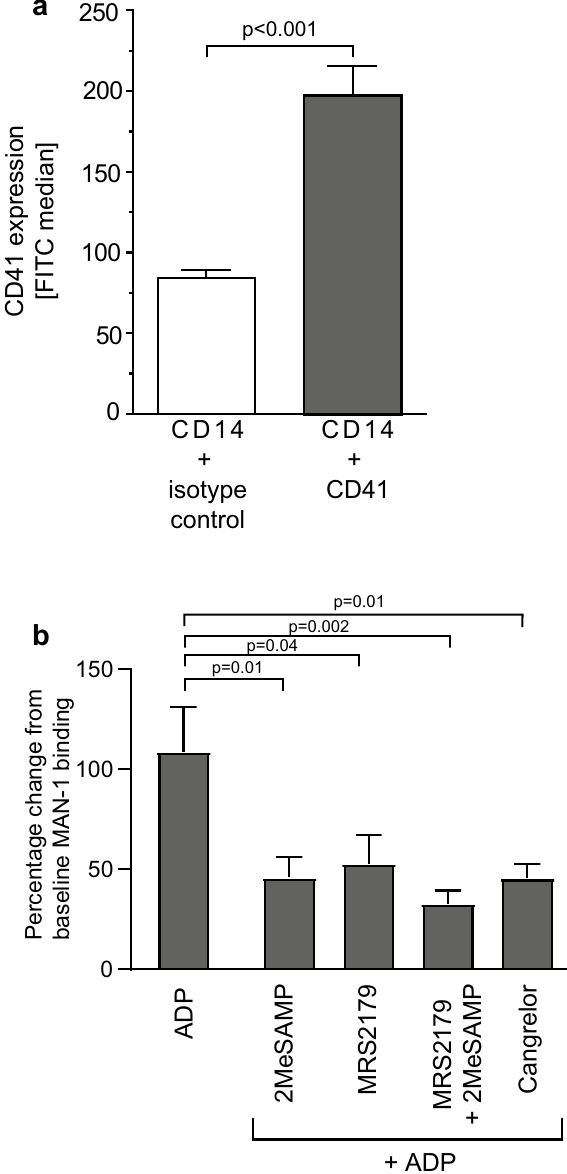
Figure 1. Monocytes are activated by ADP and inhibited by P 2 Y 1 and P 2 Y 12 receptor blockers, mediated by platelets in monocyte platelet aggregates. ( a ) CD14 + /CD41 + MPA were detected by flow cytometry in whole blood from healthy volunteers. The FITC median of all CD14 + monocytes stained with an anti-CD41 FITC antibody is presented. p -values were calculated by a Student’s t-test, n = 8. ( b ) Using flow cytometry, Mac-1 activation on monocytes was determined using the activation-specific anti-Mac-1 scFv MAN-1. MAN-1 binding is presented as percentage change from baseline which was calculated as shown in the “Methods” section. The median FITC of all CD14 + monocytes was recorded. p -values were calculated by one-way ANOVA followed by Tukey’s multiple comparison post-test, n = 6. Data are presented as mean ±